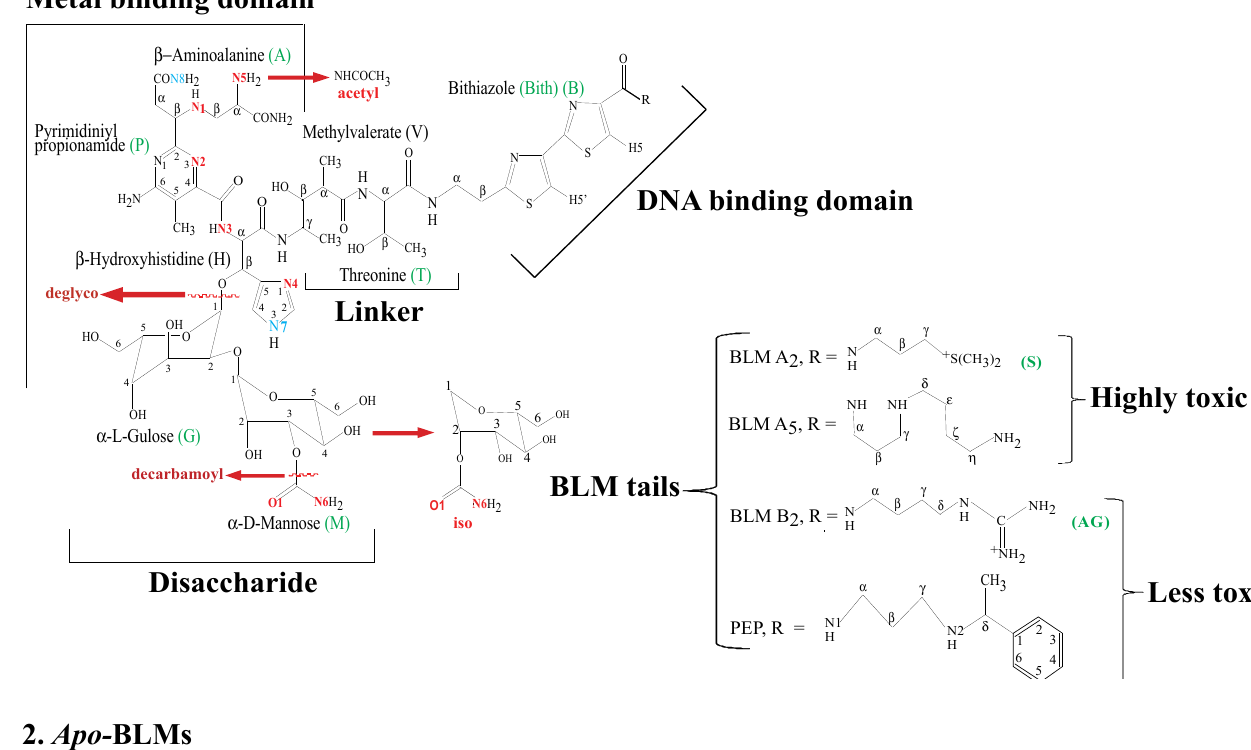
Figure 1. Structures of BLM-A most researchers are labeled and colored in red. Other coordination sites also proposed in the literature are labeled and colored in blue. BLM residue abbreviations are colored in